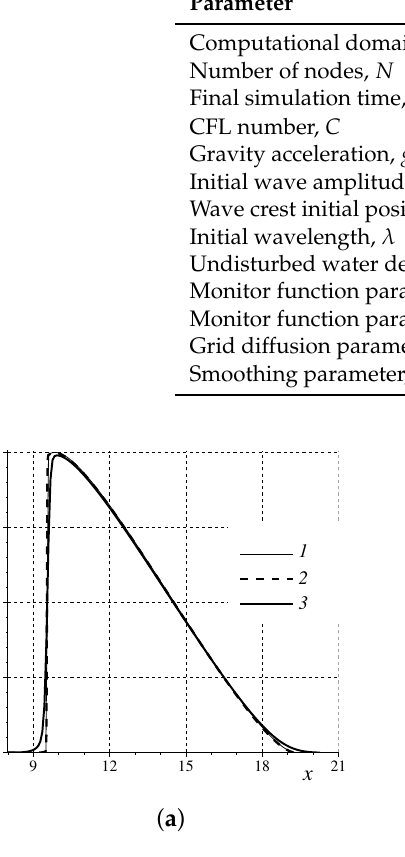
Figure 6. The shock wave formation in nonlinear shallow water equations: ( a ) A comparison of different profiles (The thin solid line (1) is the exact solution, (2) is the numerical solution on the moving mesh, and (3) is the solution on the fixed uniform mesh); ( b ) the trajectories of grid nodes in space–time. Notice that Figure 6a shows only a zoom of the computational